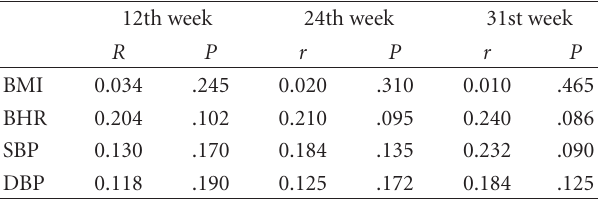
Table 7: Correlation of LF-HF ratio with body mass index (BMI), basal heart rate (HR), systolic blood pressure (SBP), and diastolic blood pressure (DBP) of subjects of control group at di ff erent weeks of gestation.